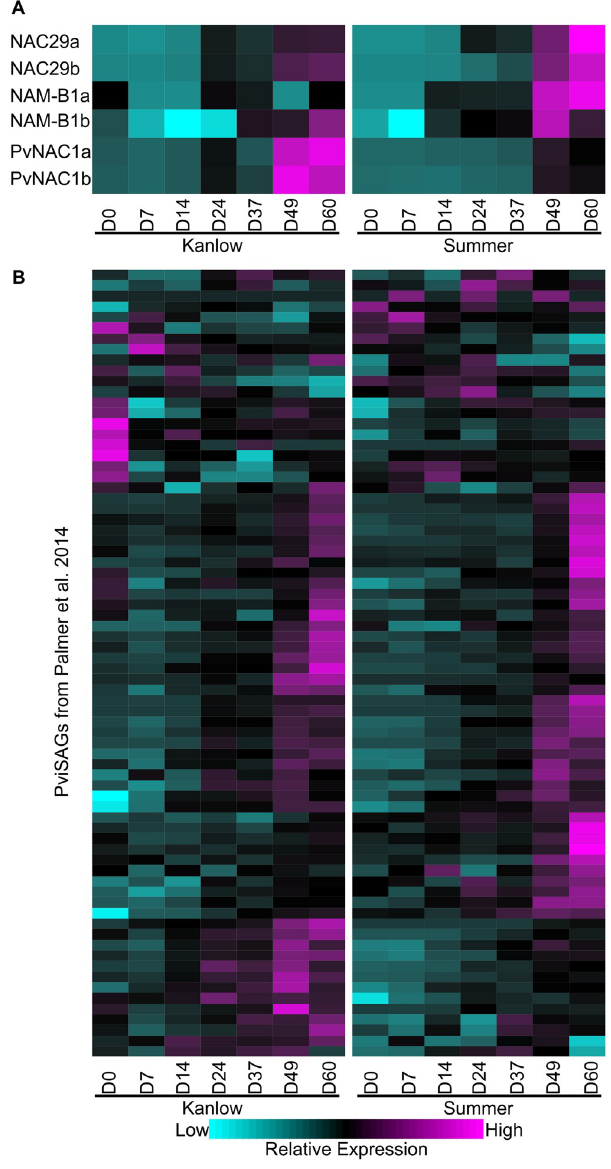
Fig 4. Expression profiles of select leaf senescence-associate genes. (A) Three NAC genes and homeologs, (B) Switchgrass homologs of Arabidopsis senescence-associated genes (SAGs). For heat maps, one way clustering was performed and the dendrograms removed for ease of presentation. Expression profiles are shown as z-scores with magenta = high expression and cyan = low/no expression. Gene identities are provided in S1 Data.